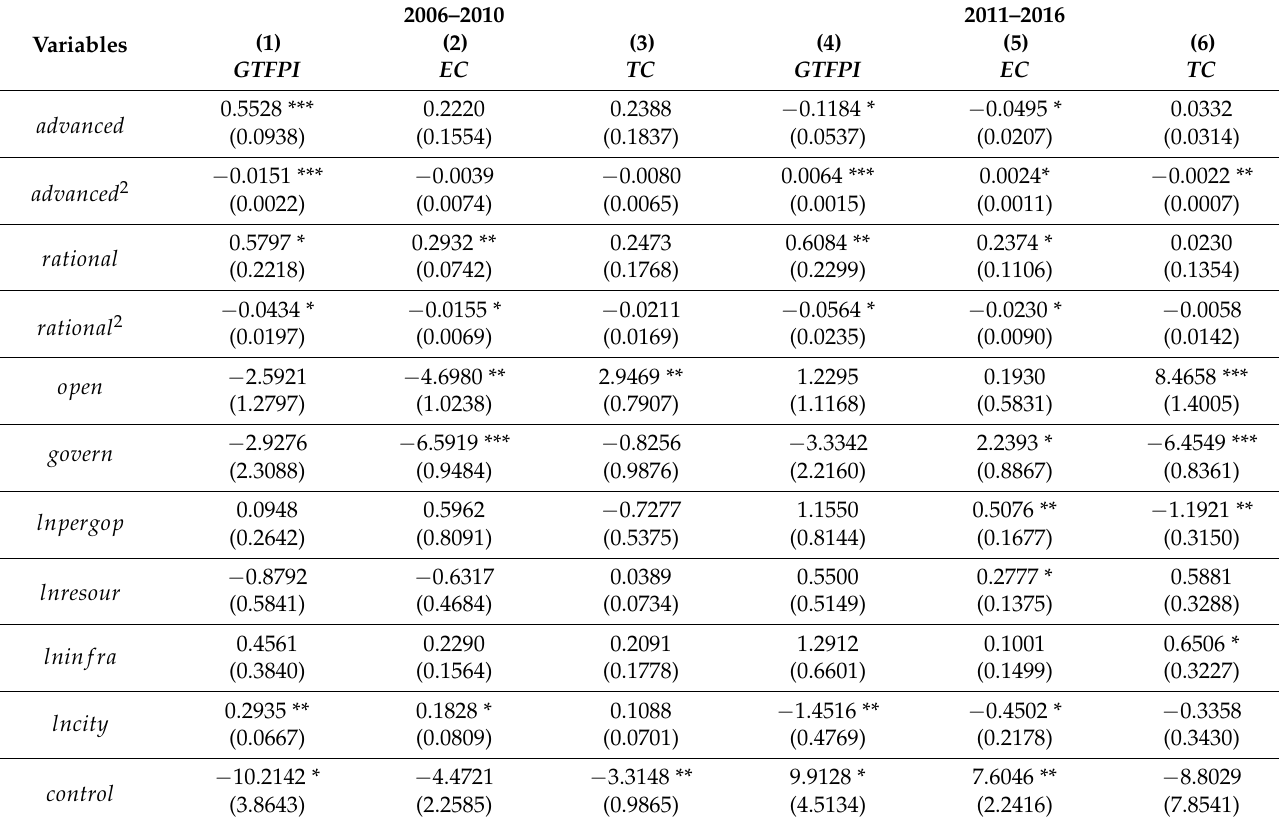
Table 4. Heterogeneity Test Based on Two